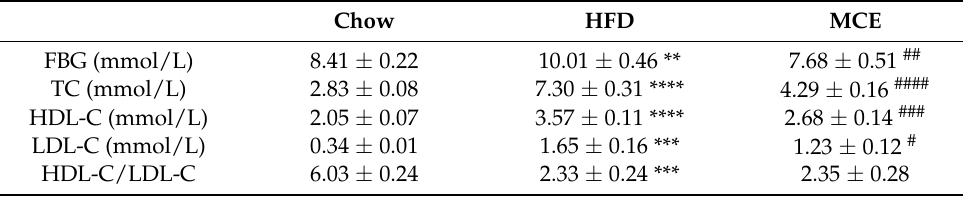
Table 2. Effects of MCE supplementation on FBG and serum lipid profiles in HFD-fed